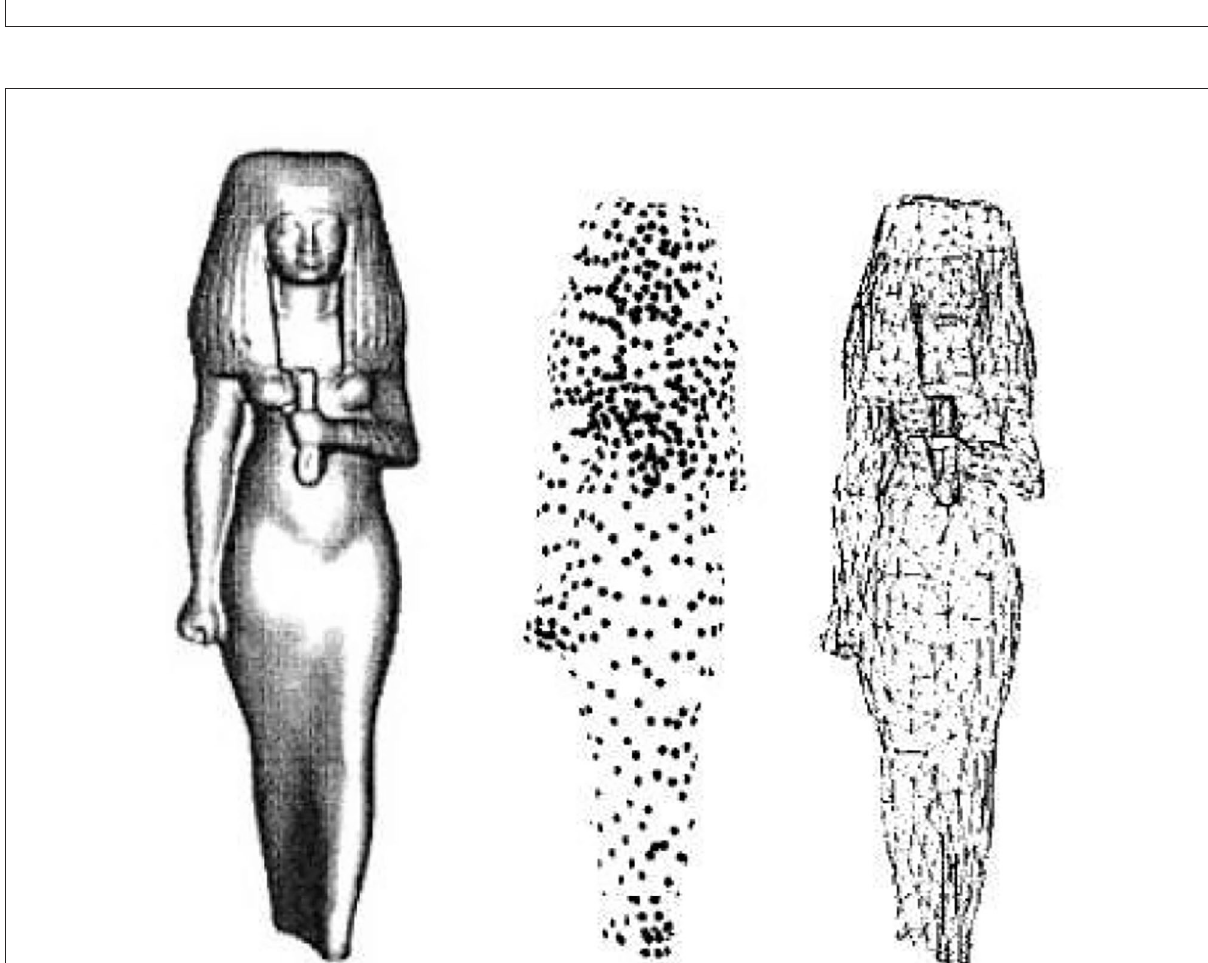
FIGURE2 Iterative method